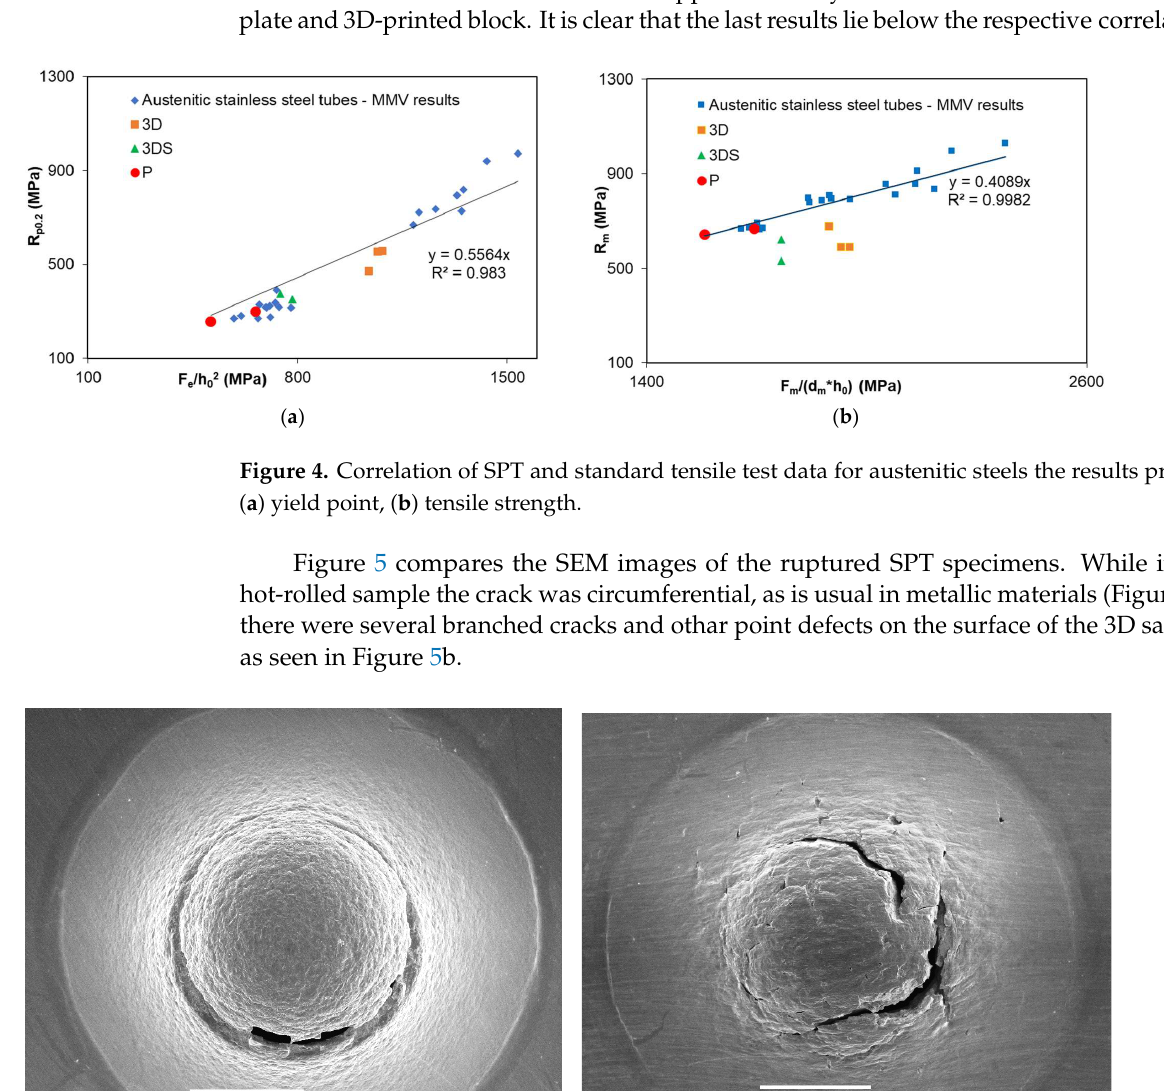
Table 3. Results of stress rupture tests of selective laser melting AISI 316L steel plate. Sample No.